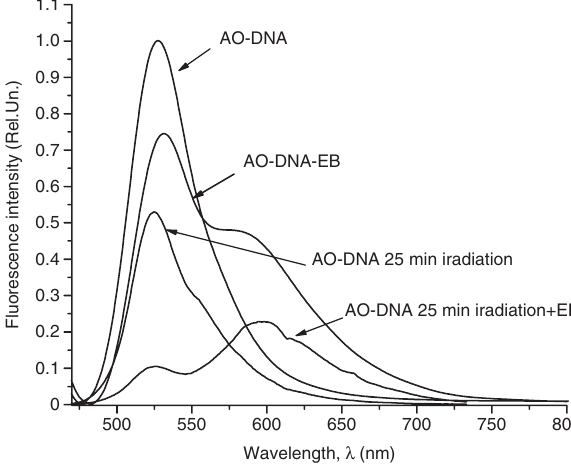
Figure 24 Influence of laser irradiation ( λ = 457 nm) on electron excitation energy transfer effectiveness from AO to EB intercalated in DNA. (A) AO-DNA; (B) AO-DNA-EB; (C) AO-DNA irradiation 25 min; (D) AO-DNA irradiation 25 min+EB. [DNA] – 7 × 10 -4 mol/l (P), [AO] – 0.14 × 10 -4 mol/l, [EB] – 0.14 × 10 -4 mol/l, [NaNO ] – 10 -2 3